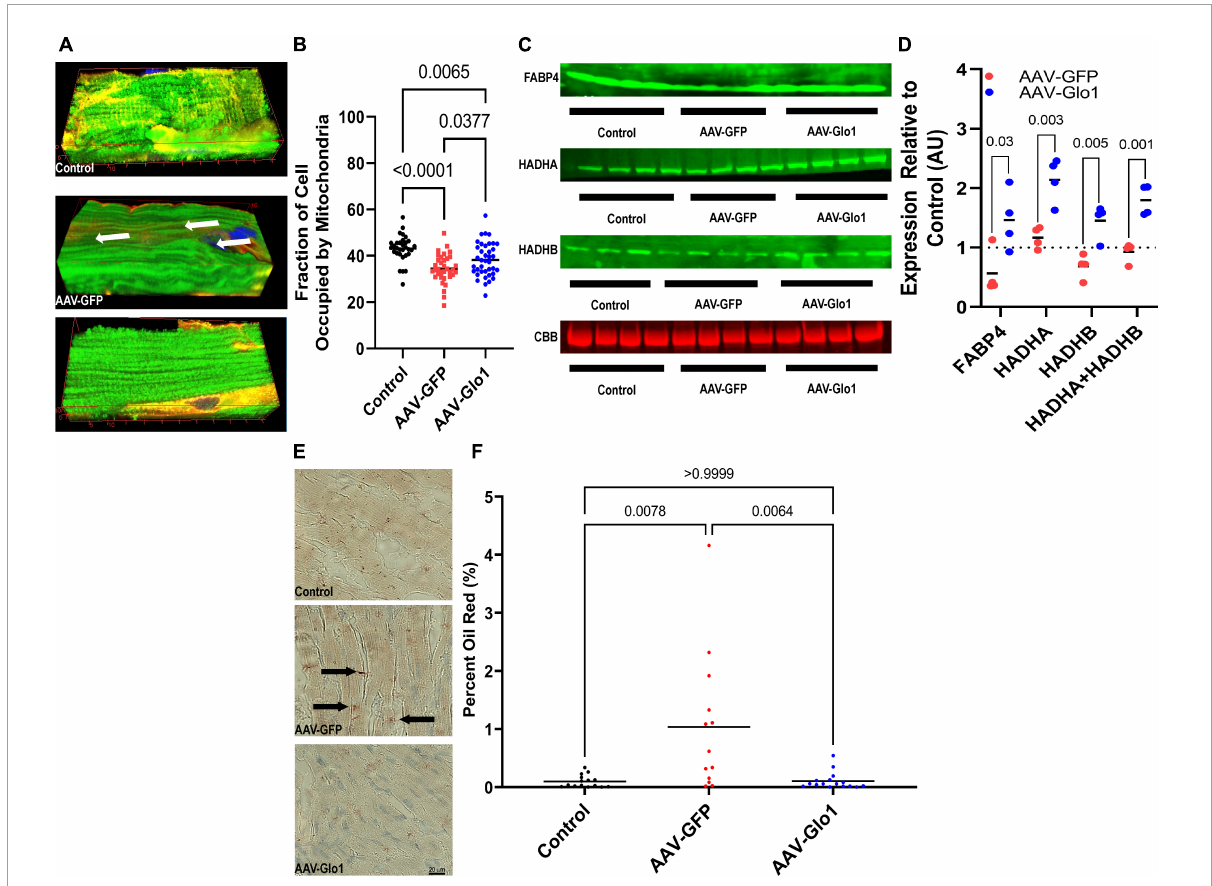
FIGURE4 AAV-Glo1 Treatment increased mitochondrial density, the abundance of fatty acid handling and metabolic proteins, and prevented lipid accumulation in the RV of MCT rats. (A) Representative three-dimensional confocal micrographs of RV cardiomyocytes stained with the mitochondrial marker TOM20 (green) and wheat germ agglutinin (red) to outline cells. Arrows highlight areas of reduced mitochondrial density. (B) Quantification of mitochondrial density in RV cardiomyocytes. p -values determined by one-way ANOVA with Tukey’s multiple comparisons test. (C) Representative Western blots and quantification (D) of protein abundance of fatty acid handling and metabolizing proteins FABP4, HADHA, and HADHB. p -values determined by unpaired t -test with control values serving as a reference of 1. n = 3 control for HADHB but n = 4 for controls for FABP4 and HADHA. (E) Representative images of RV sections subjected to Oil Red O staining. Arrows highlight intramyocardial fatty acid detection. Scale bar 40 µ m. (F) Quantification of Oil Red O staining in RV sections. p -values determined by Kruskal-Wallis test with Dunn’s multiple comparison